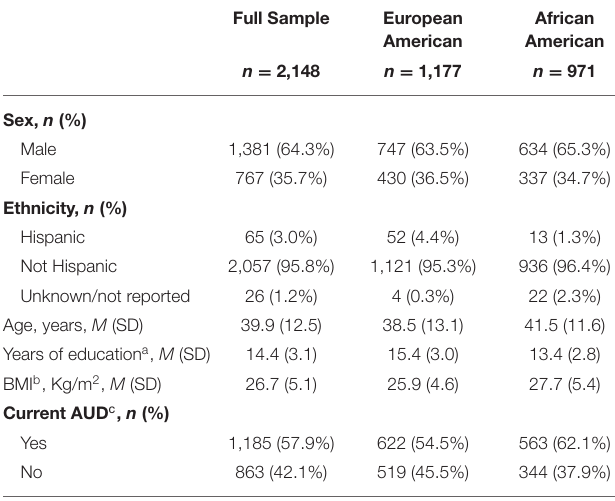
TABLE 1 | Descriptive characteristics of the